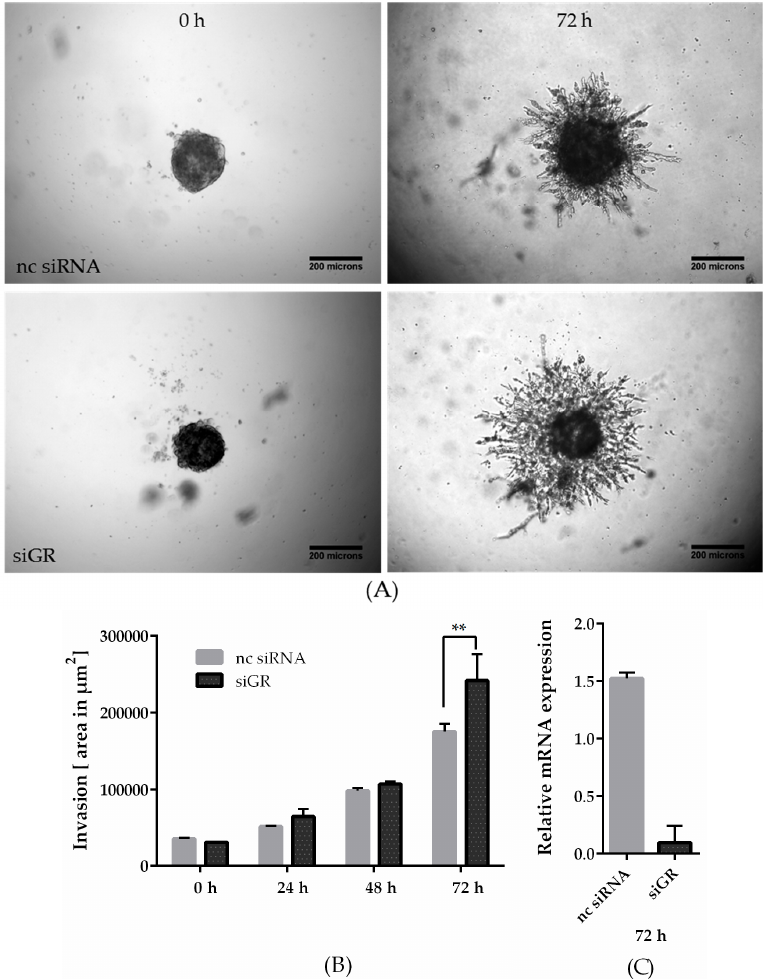
Figure 4. Knockdown of the GR α increased invasiveness of triple-negative breast cancer. ( A ) Representative images of tumor cell invasion into a 3D matrix. Knockdown of GR α was performed with the Lonza Nucleofector 2b device on day one. On day three, 3 × 10 3 cells per well were seeded into ULA round-bottom plates. Formation of spheroids was allowed for 72 h. At t = 0, matrigel was added to the spheroids to start invasion. Scale bars in black show 200 microns in length. ( B ) The invasion is depicted over a time range of three days and the area of invaded cells into matrigel was calculated with ImageJ FIJI at the respective time points. ( C ) As confirmed by qPCR analysis, GR α expression is reduced up to 94% after 72 h. The data represent means of three independent experiments. Error bars were calculated using ±SEM. p -values were calculated against noncoding siRNA (nc siRNA) control. Two stars represent a significance of p < 0.01. 2.5. Pseudopterosin Inhibited Cytokine Release in a Coculture of Primary Blood Mononuclear Cells (PBMC) and TNBC Cells The microenvironment plays a critical role in breast cancer carcinogenesis [32]. TAMs are the drivers of breast-cancer-cell invasion [33,34]. A main characteristic of inflammatory breast cancer is the secretion of proinflammatory cytokines such as IL-6 or IL-8 by macrophages, regulating angiogenesis and promoting tumor progression [35,36]. Previously, we verified a blockade of NF- κ B-dependent cytokine expression and secretion after pseudopterosin treatment in both MDA-MB-231 and THP-1 cells [16]. In this context, GR α knockdown led to the failure of pseudopterosin to inhibit cytokine expression. Furthermore, as shown previously, stimulation by the TLR4 ligand LPS leads to the production of cytokines and the subsequent secretion into the